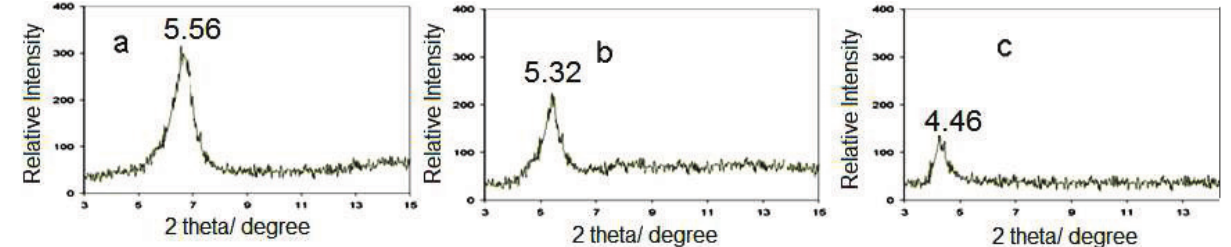
Figure 2. X-ray diffraction patterns of Organoclay ( a ), PA-nanocomposite films 3a (b) and 3b (c) .